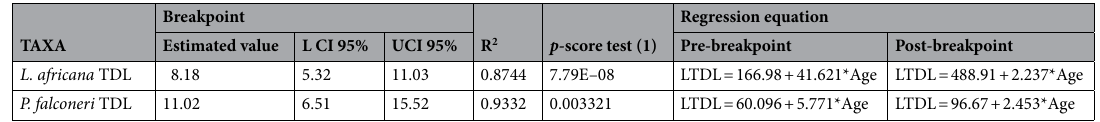
Table 2. Piecewise regressions of tibia diaphyseal lengths of L. africana and P. falconeri. (1) If p -value < 0.05, the differences between slopes are significant. LCI lower confidence interval, UCI upper confidence interval.